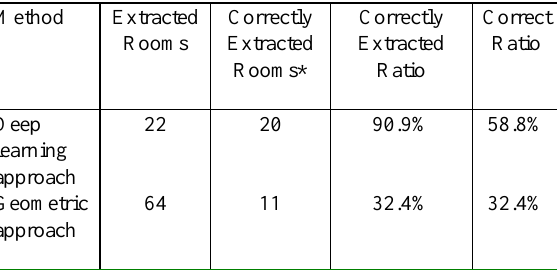
Figure 8. Total loss of the extraction result